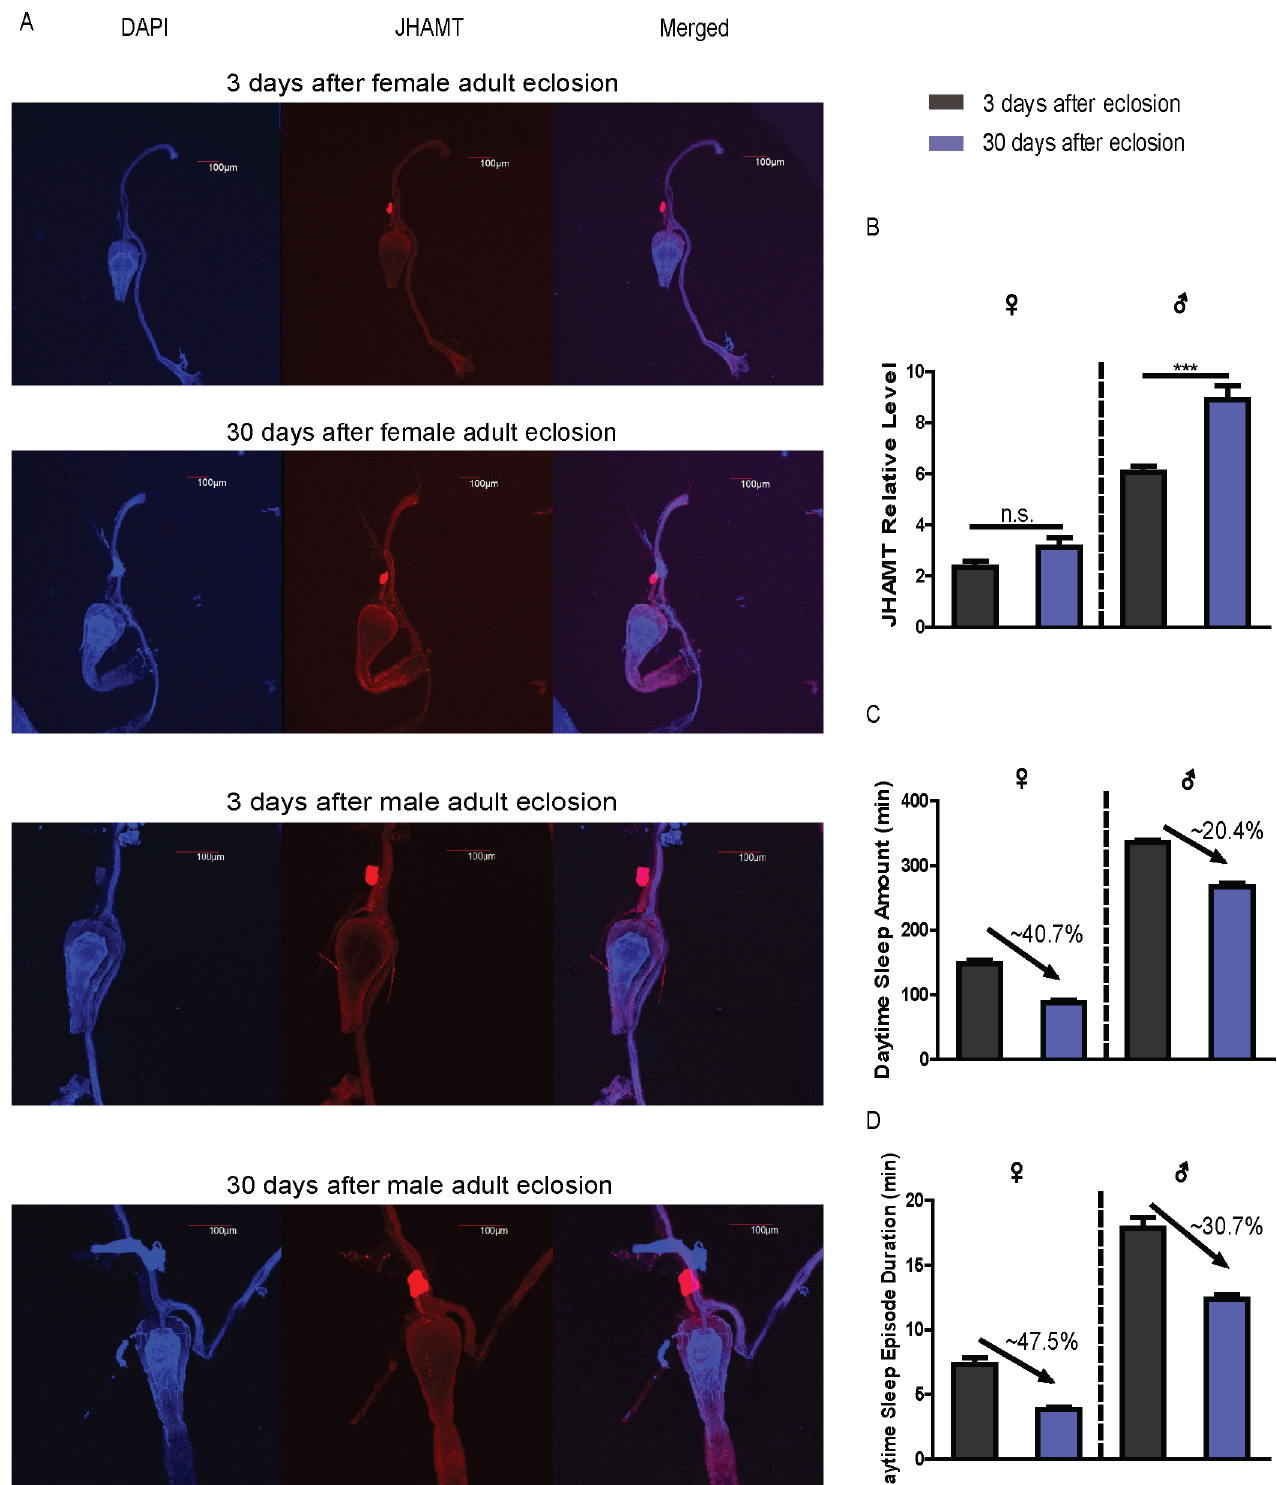
Fig 7. Contributions of JH to sleep decrease in flies’ aging process. (A) JHAMT expression in 3 rd day adults and 30 th day adults. The first row: 3 rd day female; second row: 30 th day female; third row: 3 rd day male; fourth row: 30 th day male. The blue represents DAPI, the red represents anti-JHAMT, and the third column represents co-localization of DAPI and anti-JHAMT. (B) Quantification of Fig 7A. The gray column represents 3 rd day flies, the blue column represents